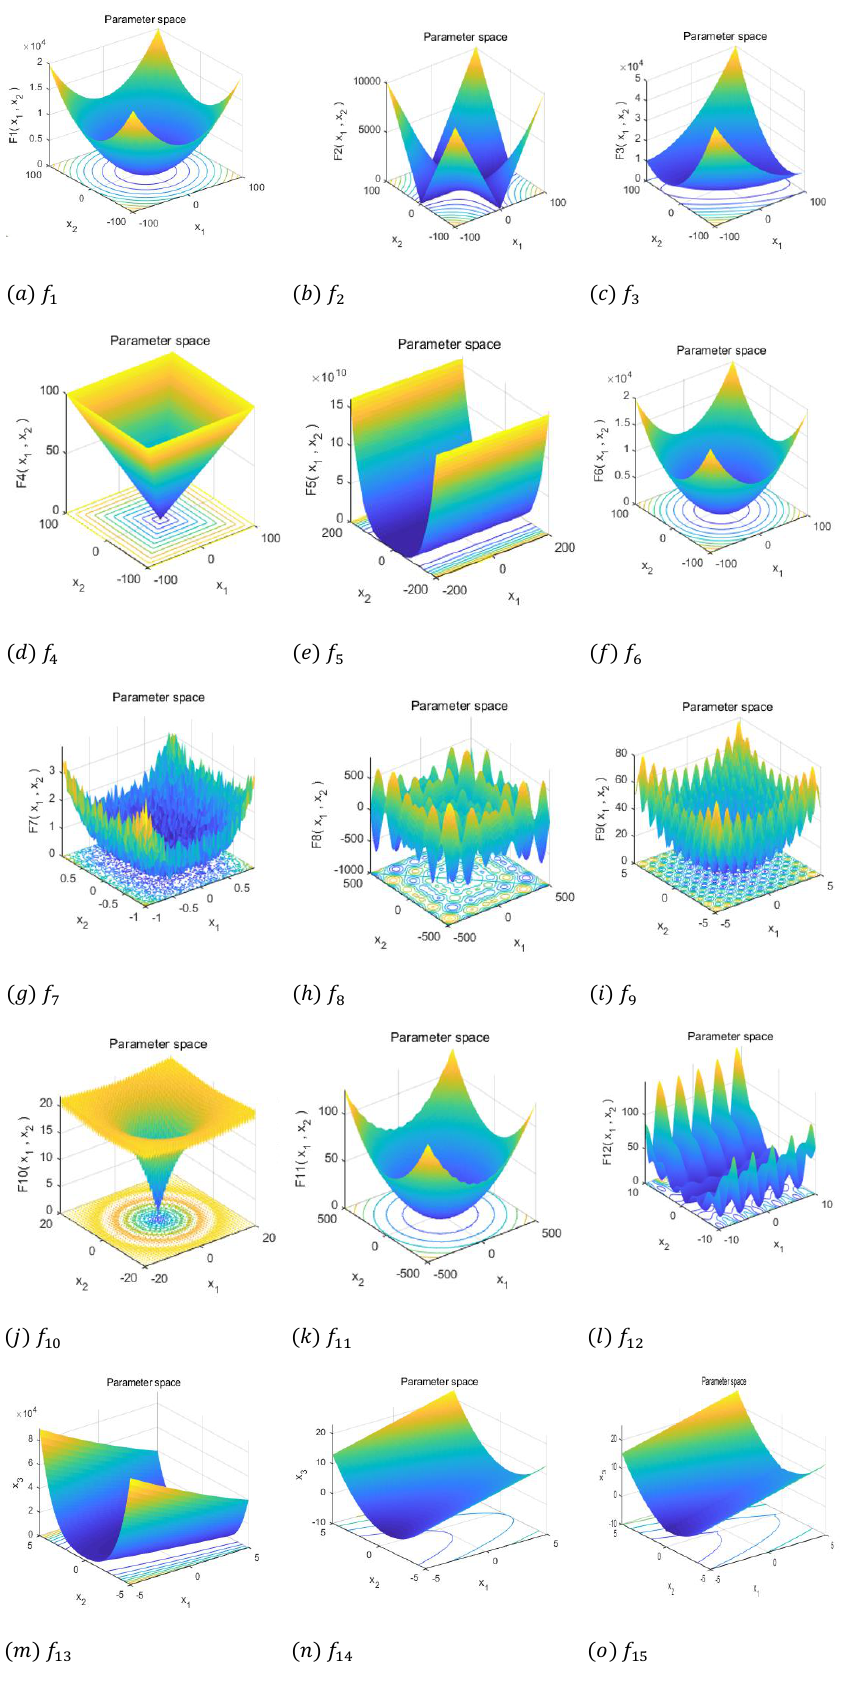
Figure 3. Three-dimensional diagrams of the test functions.